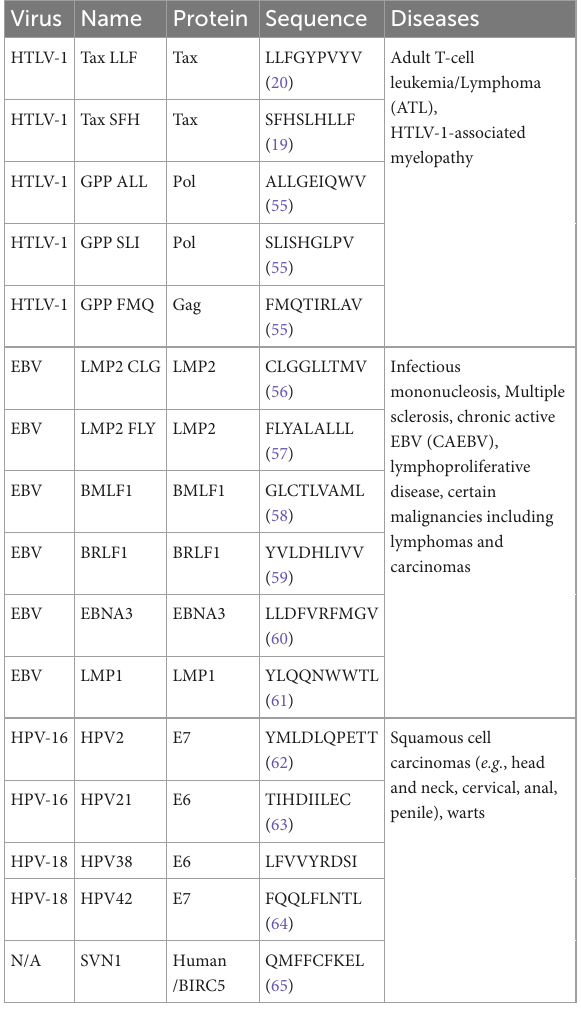
TABLE 1 HLA-A2 restricted peptides from viral driven diseases tested in the AIM ACT system. Virus